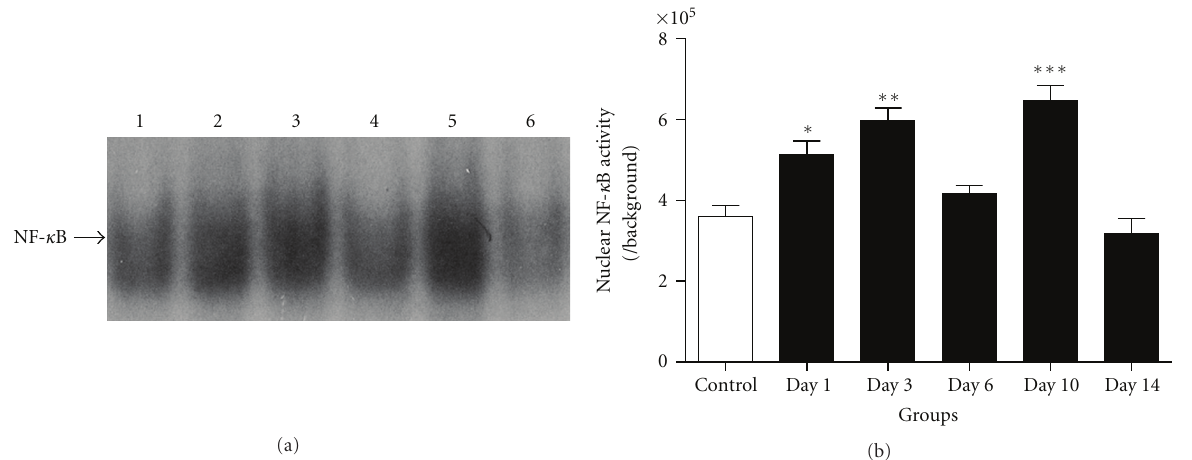
Figure 3: NF- κ B activity in brain cortex was detected by EMSA in control, day 1, day 3, day 6, day 10, day 14 groups (lane 1, 2, 3, 4, 5, 6 in (a) resp.; n = 4 per group). NF- κ B activity showed significant increasing in day 1, day 3 and day 10 group ( P < 0 . 05, P < 0 . 01, and P < 0 . 001 resp.). The NF- κ B activity showed biphasic peaks after SAH insult, ∗ P < 0 . 05, ∗∗ P < 0 . 01, ∗∗∗ P < 0 . 001 versus control group. Bars represent the mean ± SEM.